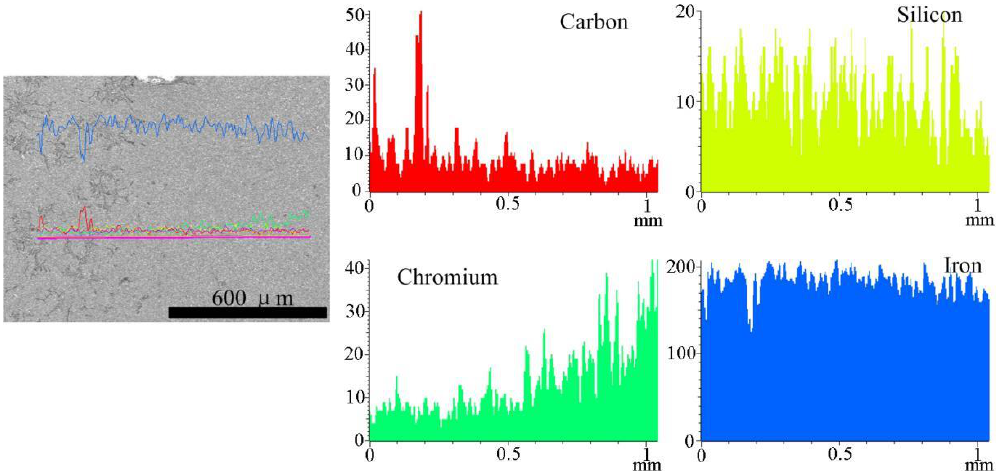
Figure 7. Line scanning results of Fe-based alloy coating in the cross-section.